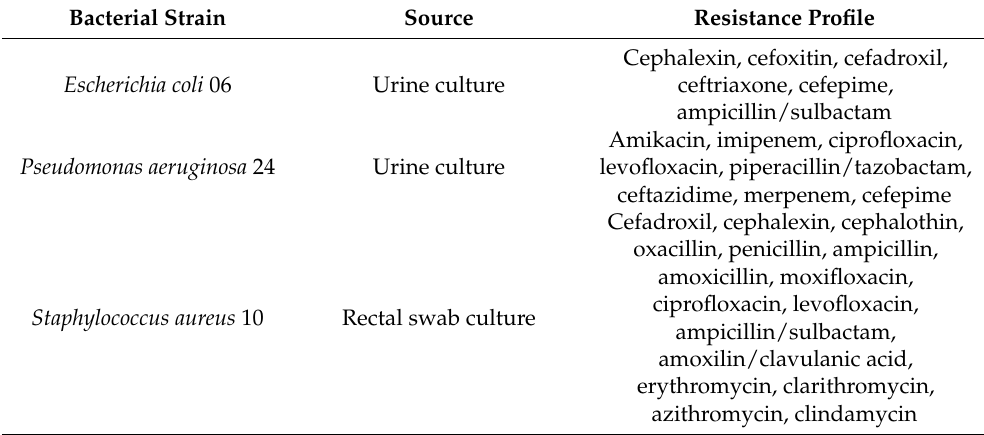
Table 3. Antibiogram of the strains used in the MIC and modulation tests with their antibiotic resistance profile and origin. Bacterial Strain Source Resistance Profile Cephalexin, cefoxitin, cefadroxil, Escherichia coli 06 Urine culture ceftriaxone, cefepime, ampicillin/sulbactam Urine